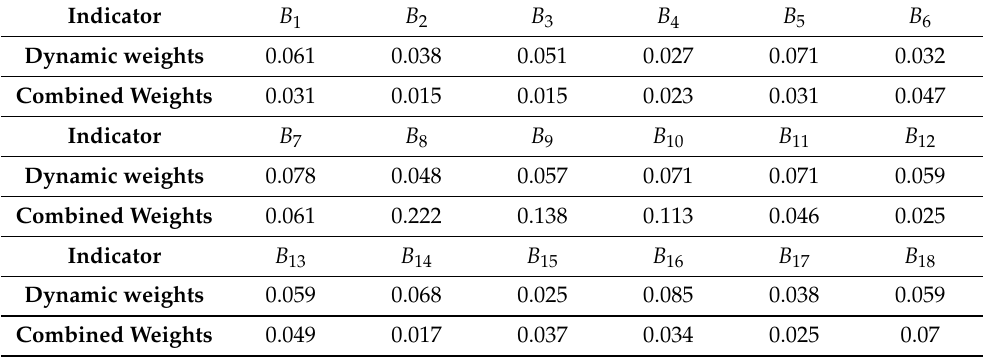
Table 11. Final weight assignments.